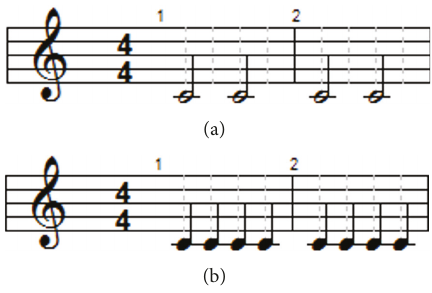
Figure 6: Slow (a) and fast (b) rhythms.